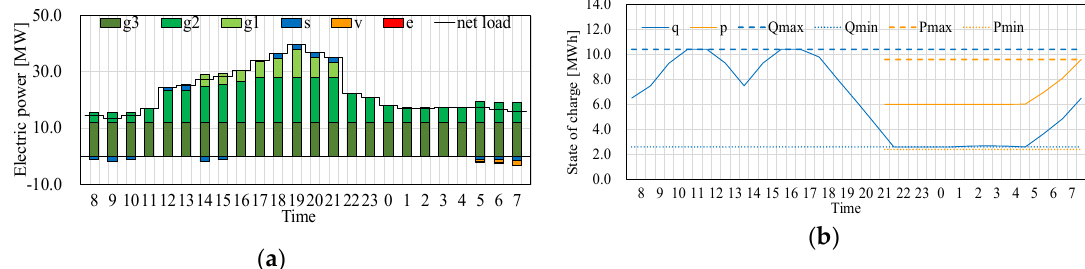
Figure 4. ( a ) Operation schedule for forecasted net load in Case 2; ( b ) SOC level in Case 2.